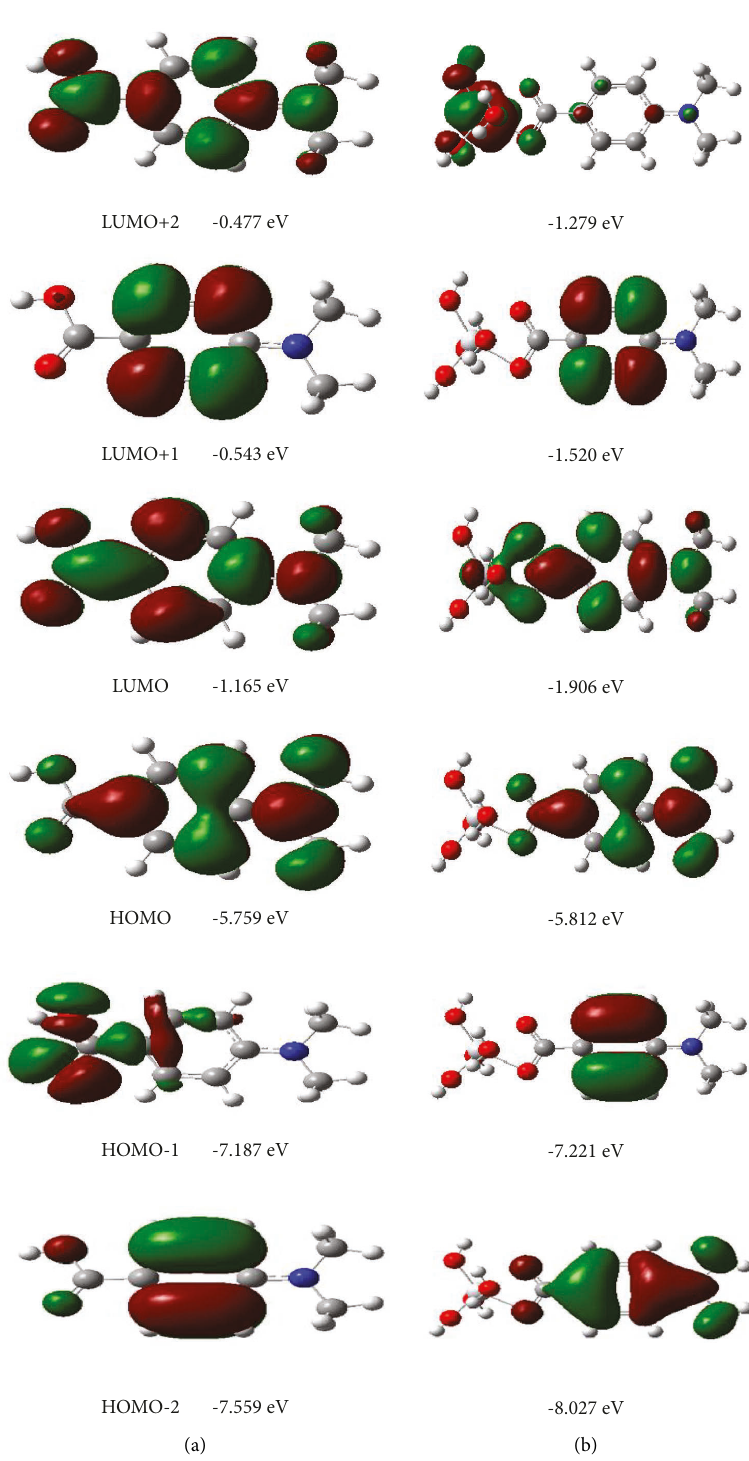
Figure 2: The Frontier molecular orbitals (FMOs) of (a) the neat 4-DMABA and (b) 4-DMABA-T +4 (OH) using the B3LYP/6-311++G ∗∗ level of